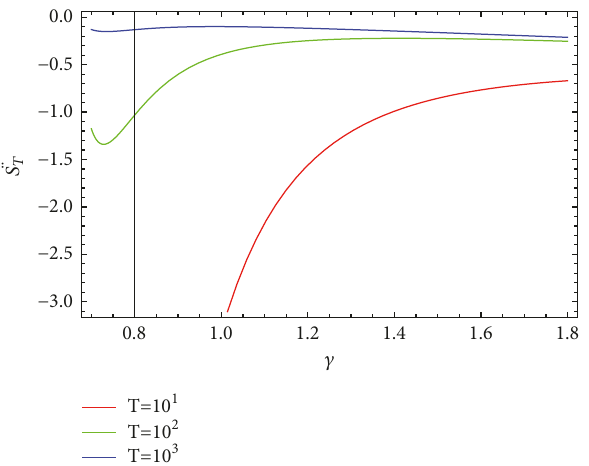
̈𝑆 𝛾 for Renyi entropy when Γ = 𝑐𝑜𝑛𝑠𝑡𝑎𝑛𝑡 𝑇 versus